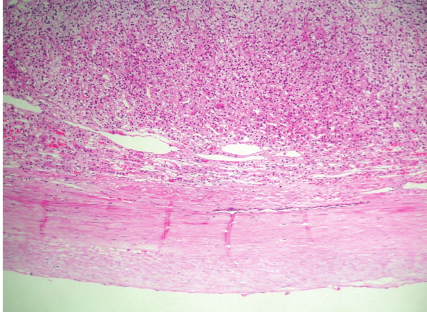
Figure 4: This photo shows a fibrocollagenous cyst wall with attached adrenal tissue (H&E stained slides).